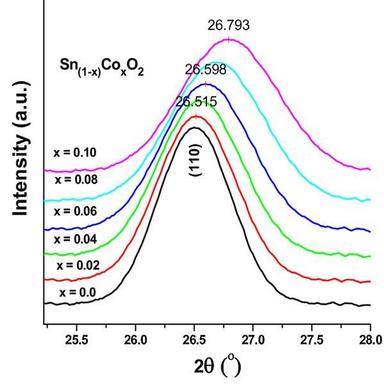
Magnified the diffraction line sharp of the distinguish crystalline peak (110) of Sn1−xCoxO2 (with 0 ≤ x ≤ 0.10) nanoparticles.